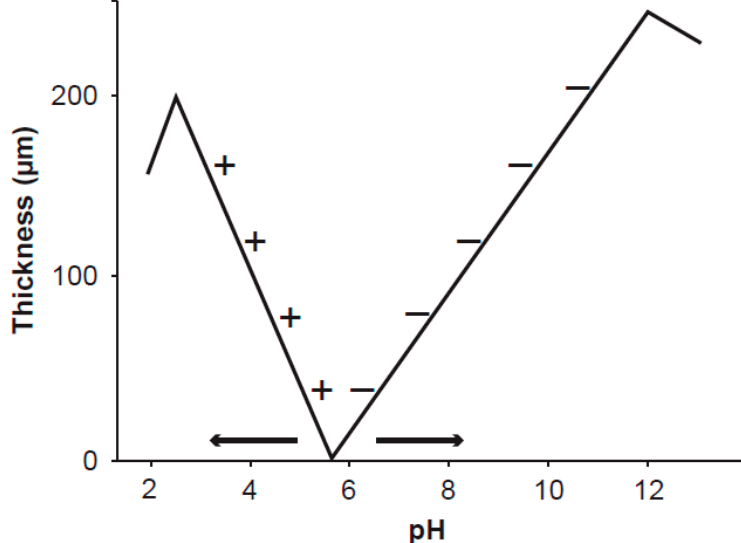
Figure 1. Schematic visualization of the thickness of the exclusion zone versus pH factor at the surface of polyvinyl alcohol gel [14]. The gel was stored in pure water at pH 5.7. The signs + and − denote positively and negatively charged particles suspended in aqueous solution at different pH and excluded from the exclusion zone. The exclusion zone is formed by the static electric field emanating from the gel surface charge. The measured curves are important for understanding the ordered water layers around mitochondria. As the inner membrane potential of mitochondria depends on the level of oxidative metabolism ( i.e. , on the intensity of the static electric field), the working point shifts along the curve and very likely even the point of zero thickness may move as shown by the arrows. The shifts of the working point along the pH axis seem to explain Warburg’s “more structure” in normal